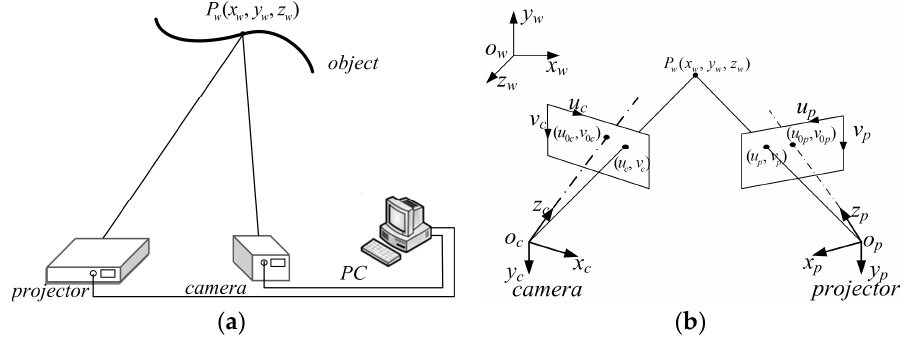
Figure 1. The principle of the structured light three-dimensional (3D) measurement system: ( a ) system components; and, ( b ) measurement principle.